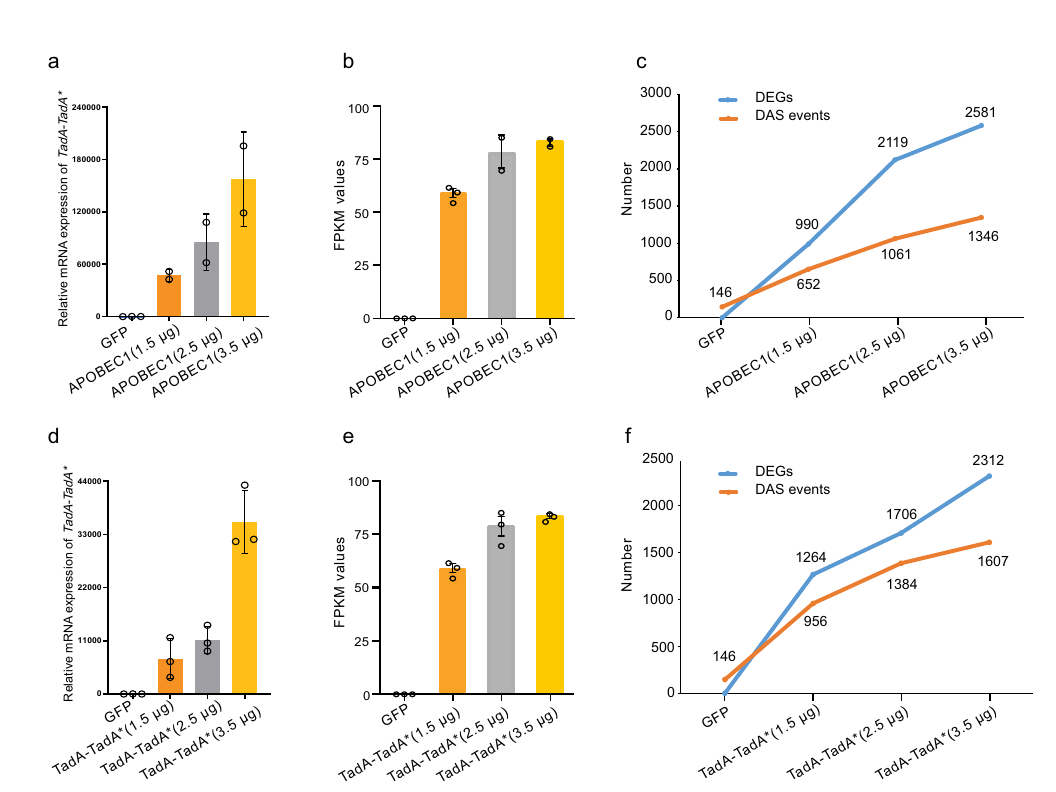
Fig. 6 Increased expression of deaminases induces an increase in DEGs and DAS events. a Expression of APOBEC1 detected by qPCR in HEK293T cells transfected with a gradient concentration of APOBEC1 (0, 1.5, 2.5, and 3.5 μ g). All values are presented as mean ± sem. b FPKM values of APOBEC1 calculated by RNA-seq data in HEK293T cells transfected with a gradient concentration of APOBEC1 (0, 1.5, 2.5, and 3.5 μ g). All values are presented as mean ± sem. c The number of DEGs and DAS events in cells transfected with a gradient concentration of APOBEC1 (0, 1.5, 2.5, and 3.5 μ g). Corresponding data were presented in Supplementary Data 14. d Expression of TadA detected by qPCR in HEK293T cells transfected with a gradient concentration of TadA-TadA* (0, 1.5, 2.5, and 3.5 μ g). All values are presented as mean ± sem. e FPKM values of TadA calculated by RNA-seq data in HEK293T cells transfected with a gradient concentration of TadA-TadA* (0, 1.5, 2.5, and 3.5 μ g). All values are presented as mean ± sem. f The number of DEGs and DAS events in cells transfected with a gradient concentration of TadA-TadA* (0, 1.5, 2.5, and 3.5 μ g). Error bars represent SD for two or three independent